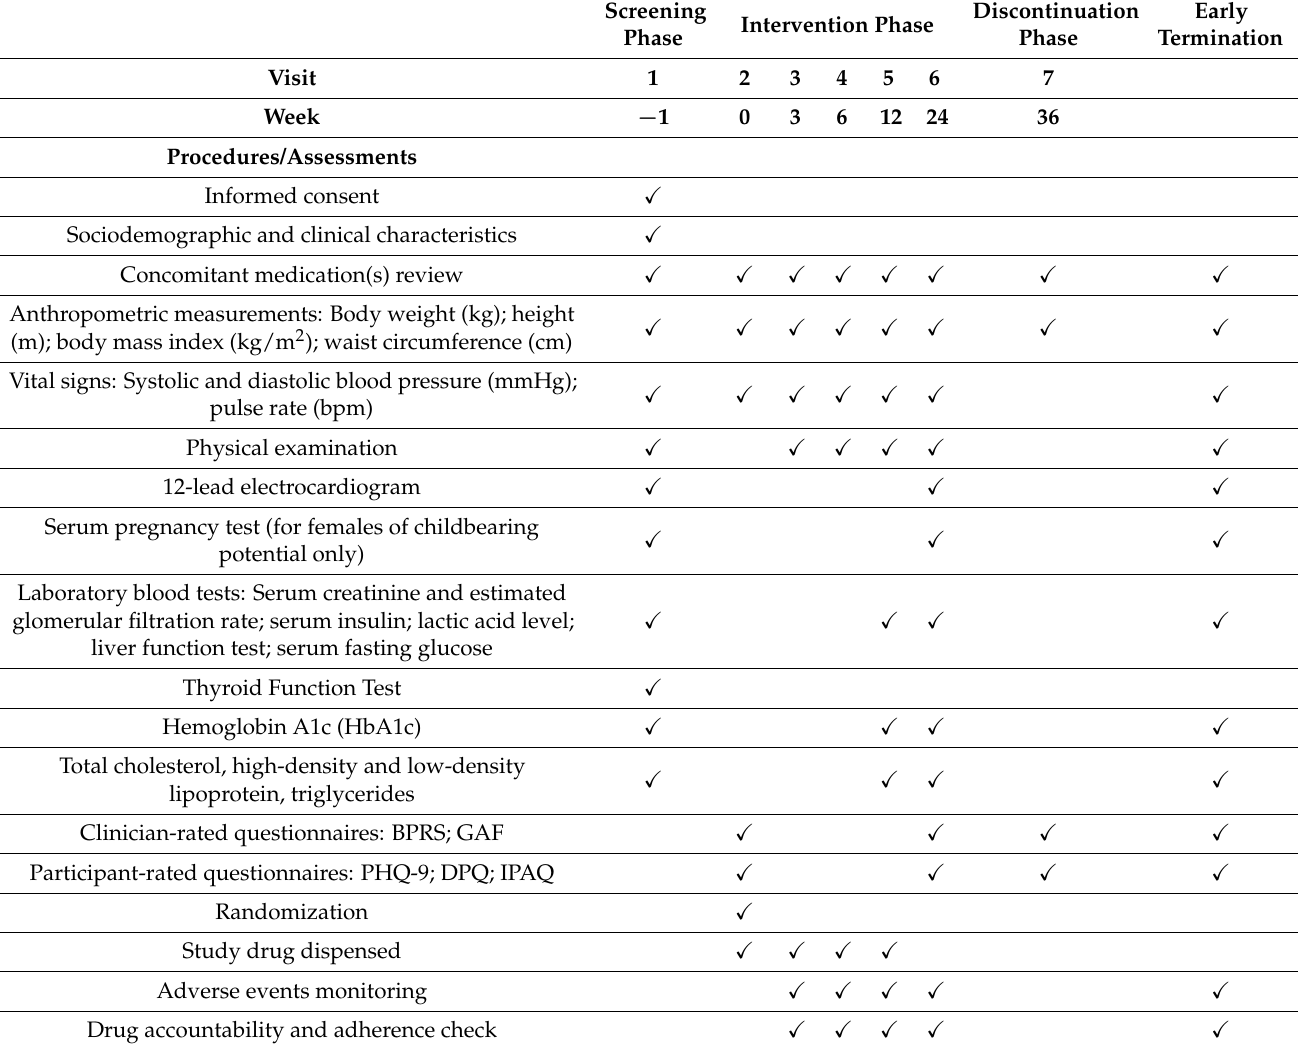
Table 1. Schedule of procedures and assessments administered to participants at each study visit. Discontinuation Screening Intervention Phase Phase Phase